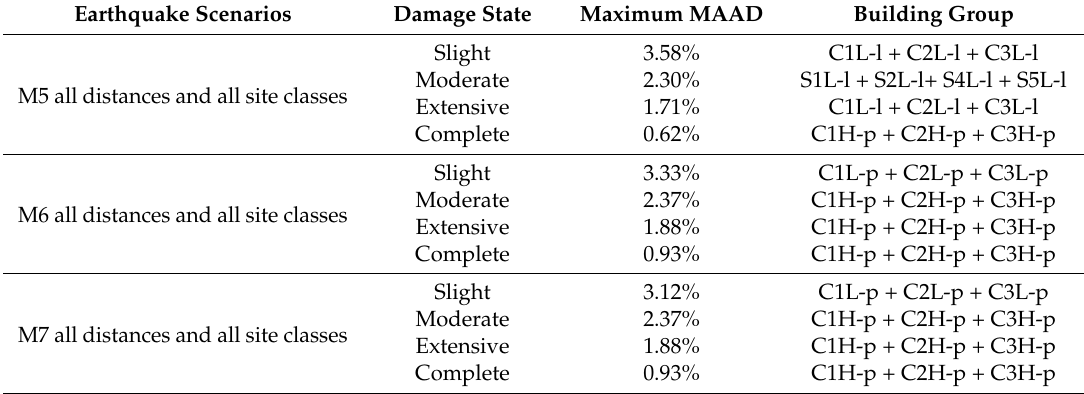
Table 4. Building groups with maximum deviation between damage probability data points and implicit fragility function observed for 24 building classes—MAAD